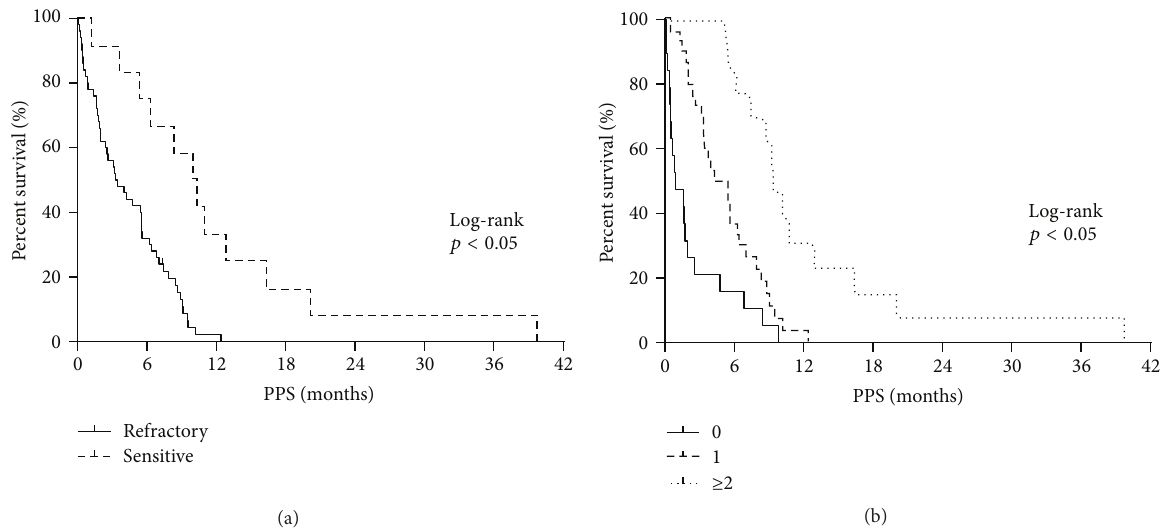
Figure 4: (a) Kaplan-Meier plots showing postprogression survival (PPS), according to the type of relapse. Refractory relapse, median = 3.3 months; sensitive relapse, median = 10.0 months. (b) Kaplan-Meier plots showing postprogression survival (PPS), according to the number of regimens after progression. No further regimen, median = 0.8 months; 1 regimen, median = 4.8 months; ≥ 2 regimens, median = 9.5